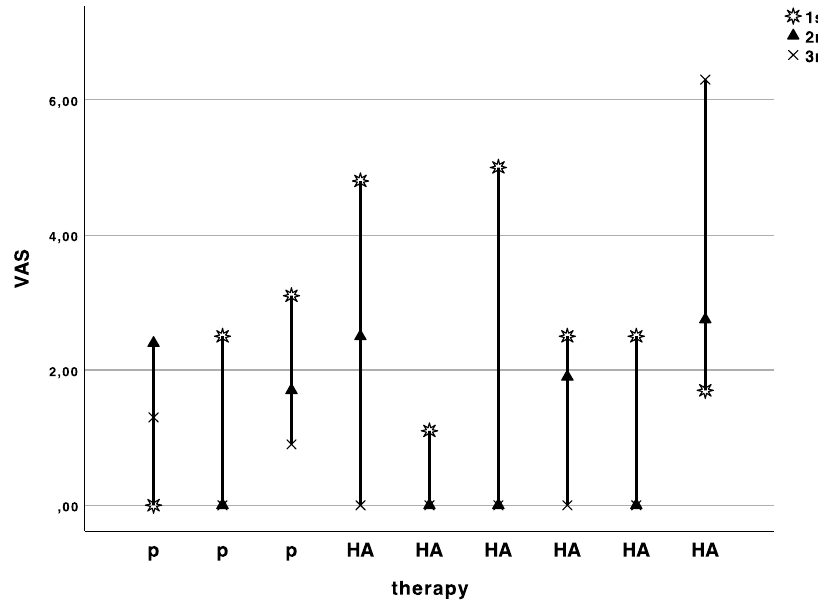
Figure 3. Curves indicating the visual analogue scale values in cm for each patient at baseline (1st appointment), cross over (2nd appointment), and recall (3rd appointment). P indicates the patients starting with placebo, and HA indicates the patients starting with hyaluronic